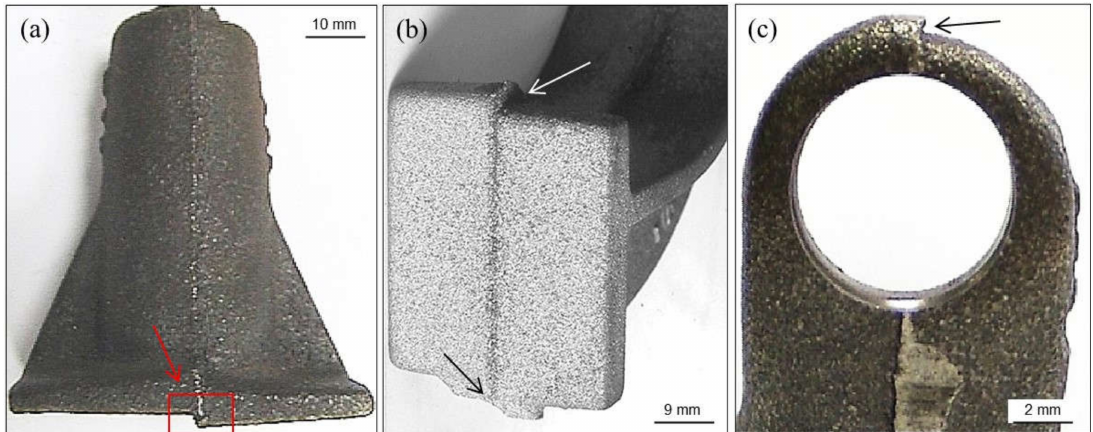
Figure 47. Mismatch defect in ductile iron castings: ( a , b ) steps found in the ends of the partition lines and ( c ) change of the casting section after machining a hole in the